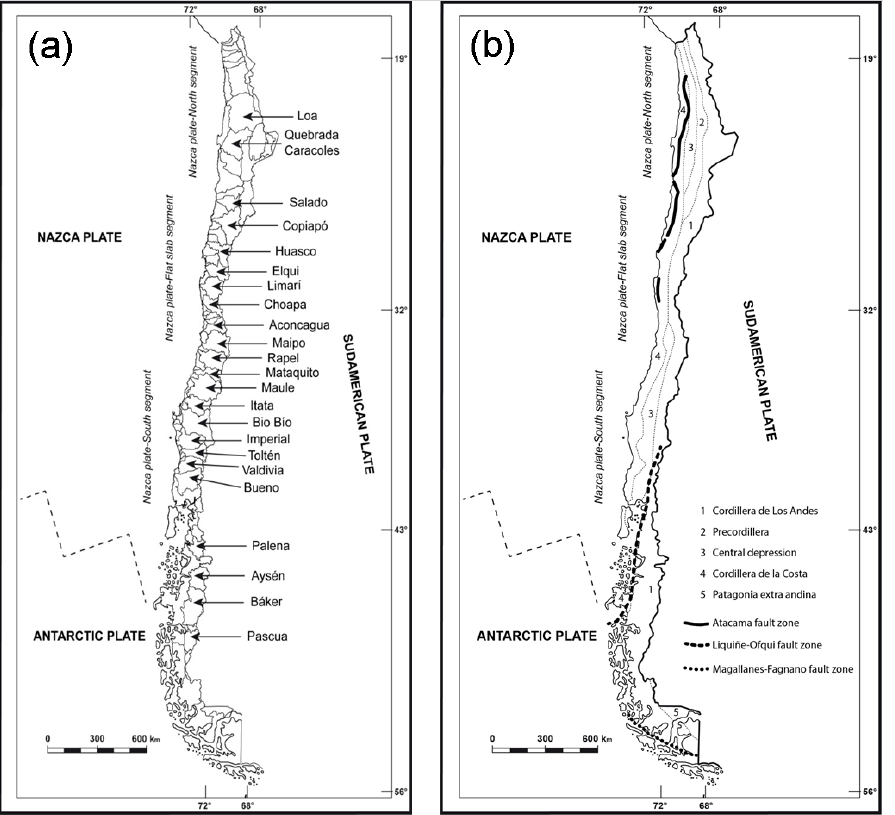
Figure 1. ( a ) Localization of the 23 large basins used in the present study. The tectonic segments of Chilean territory, ordered from north to south is also shown. ( b ) the morph-structural bands, 1: Cordillera de los Andes, 2: Precordillera, 3: Central Depression, 4: Cordillera de la Costa and 5: Patagonia. In the same drawing the main fault systems Table 2. Morphometric parameters of large networks, where A is the drainage area, i m the mean slope, H m the mean elevation and Ω the maximum order of each network according to Strahler’s hierarchical ordering. The indices F , C , E and the drainage density ρ , were included for